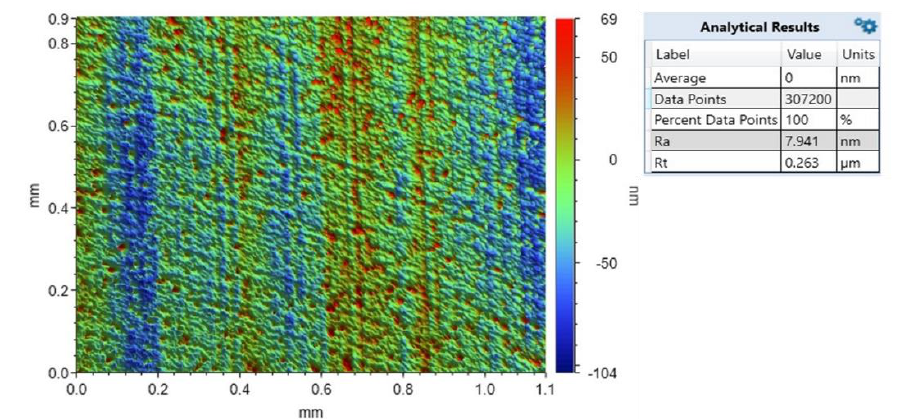
Figure 9. Friction test on Bruker UMT Tribolab.